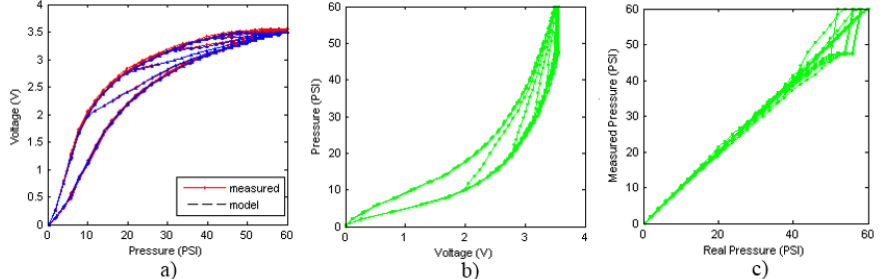
Figure 13. Compensation for descending curves with ELAM method ( a ) ELAM direct model; ( b ) ELAM inverse model; ( c ) Sensor output pressure versus real pressure after ELAM compensation.